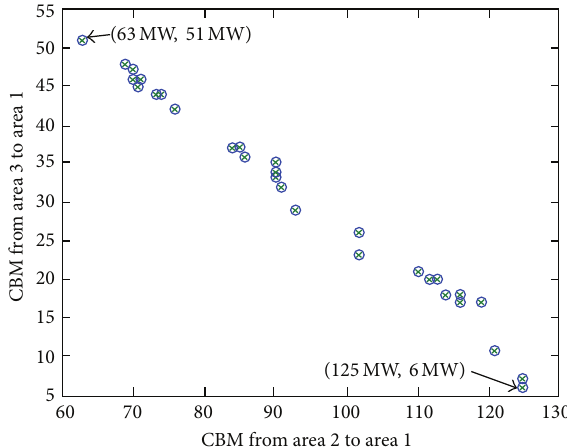
Figure 5: Pareto optimal fronts of CBMs for the two transfer cases.